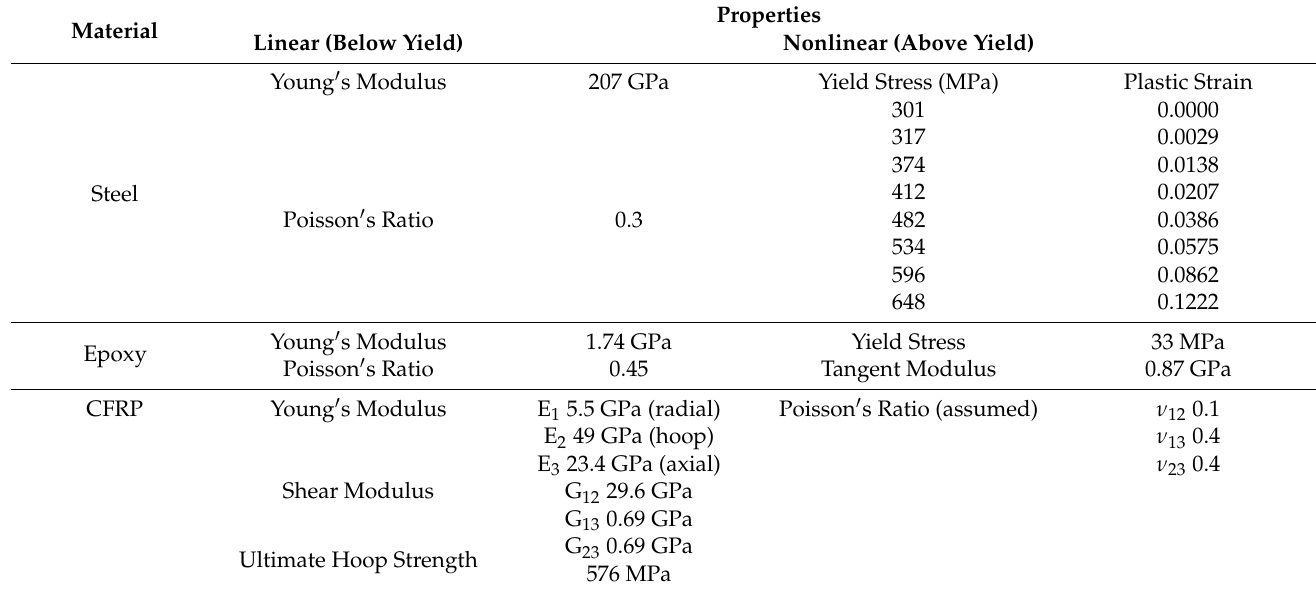
Table 1. Material properties in finite element (FE) model (After Duell et al. 2008